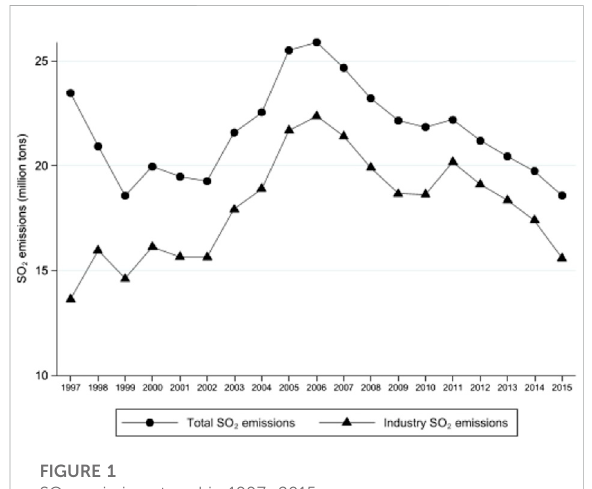
FIGURE 3 Estimated coef fi